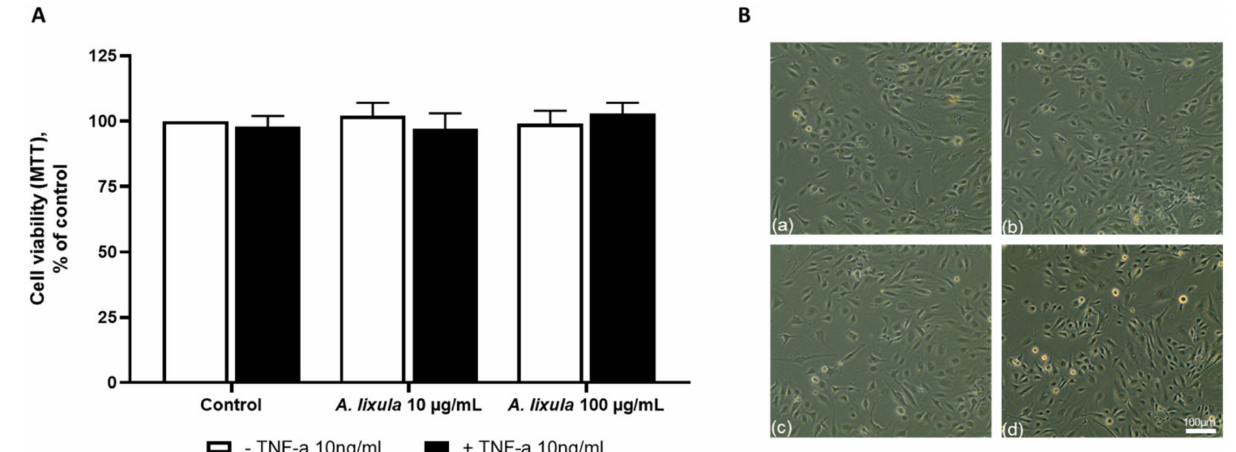
Figure 1. Effect of A. lixula extract on endothelial cell viability. HMEC-1 were treated with A. lixula extract for 4 h at the concentrations indicated, and then either treated with 10 ng/mL TNF- α or left untreated for 18 h. ( A ) Cell viability was assessed by the MTT assay and data (means ± S.D., n = 3) expressed as percent of unstimulated control. In ( B ), representative phase-contrast images (10 × magnification) of cells after treatments are shown. ( a ) control; ( b ) TNF- α 10 ng/mL; ( c ) A. lixula extract 10 µ g/mL + TNF- α ; ( d ) A. lixula extract 100 µ g/mL + TNF- α